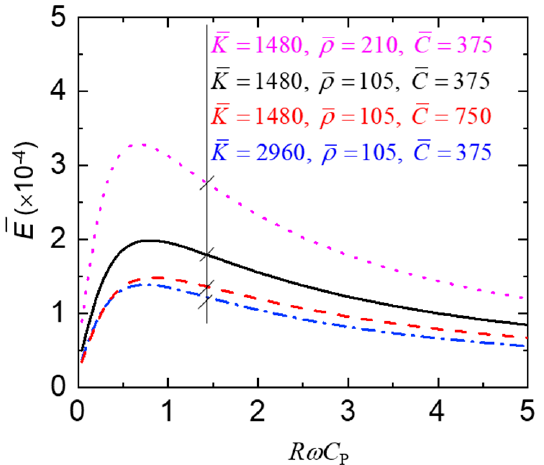
Figure 4. Influence of the piezoelectric energy harvesting system’s intrinsic parameter R ω C P on the normalized energy E .